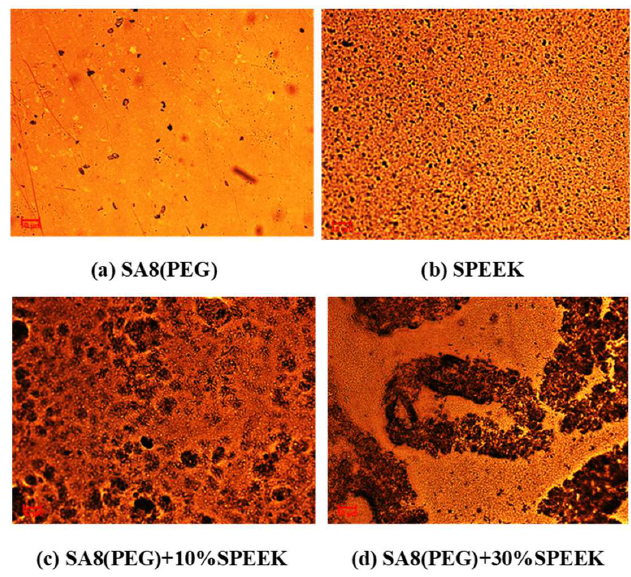
Figure 26. The morphology diagram of SA8 blended with PEG and sPEEK.